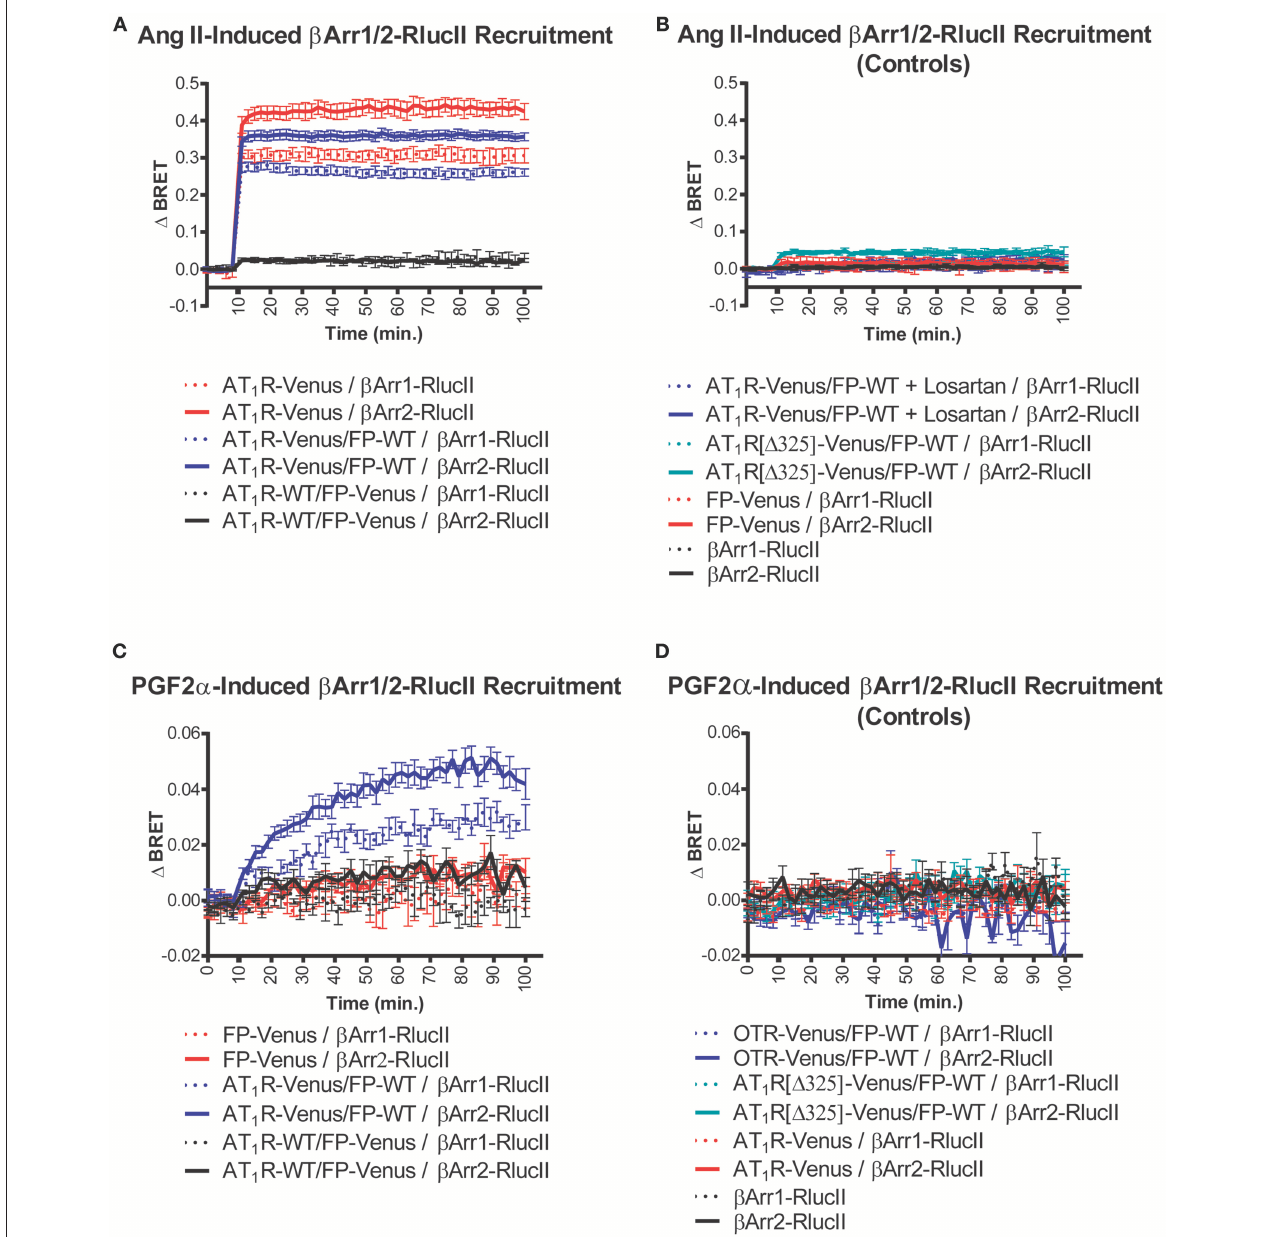
FIGURE 1 | Symmetric and asymmetric recruitment of β -arrestin 1/2 to the AT1R/FP dimer by Ang II and PGF2 α , respectively. (A) Ang II (1 µ M) induced a rapid and sustained symmetric recruitment of β -arrestin 1-RlucII (dashed lines; t 1 / 2 < 2min.) and β -arrestin 2-RlucII (full lines; t 1 / 2 < 2min) to AT1R-Venus alone (purple lines) and to a lesser extent, the AT1R-Venus/FP-WT dimer (blue lines), but not to the AT1R-WT/FP-Venus dimer (black lines). (B) No and very small responses were detected with Ang II by blocking AT1R-Venus with losartan (100 µ M) (dashed and full blue lines), and when an AT1R[ 1 325]-Venus mutant deficient for both β -arrestin 1/2-RlucII recruitments (dashed and full blue-green lines) were used in the context of the dimer, respectively. Responses were all specific to AT1R since no responses were detected for FP-Venus alone (dashed and full red lines) and β -arrestin 1/2-RlucII alone (dashed and full black lines). (C) PGF2 α (1 µ M) induced a slower, yet sustained asymmetric recruitment of β arr1-RlucII (dashed blue lines; t 1 / 2 = 20min) and β -arrestin 2-RlucII (full blue lines; t 1 / 2 = 17min) to the AT1R-Venus/FP-WT dimer only, but not to FP-Venus alone (dashed and full red lines) and the AT1R-WT/FP-Venus dimer (dashed and full black lines). (D) No responses were detected with PGF2 α when OTR-Venus (dashed and full blue lines) and an AT1R[ 1 325]-Venus mutant deficient for both β -arrestin 1/2-RlucII recruitment (dashed and full blue-green lines) were used in the context of the dimer. Responses were all specific to FP since no responses were detected for AT1R-Venus (dashed and full red lines) and β -arrestin 1/2-RlucII alone (dashed and full black lines). Data represent mean ± s.e.m. of independent experiments [biological replicates, each performed in triplicate ( n = 3–15)].